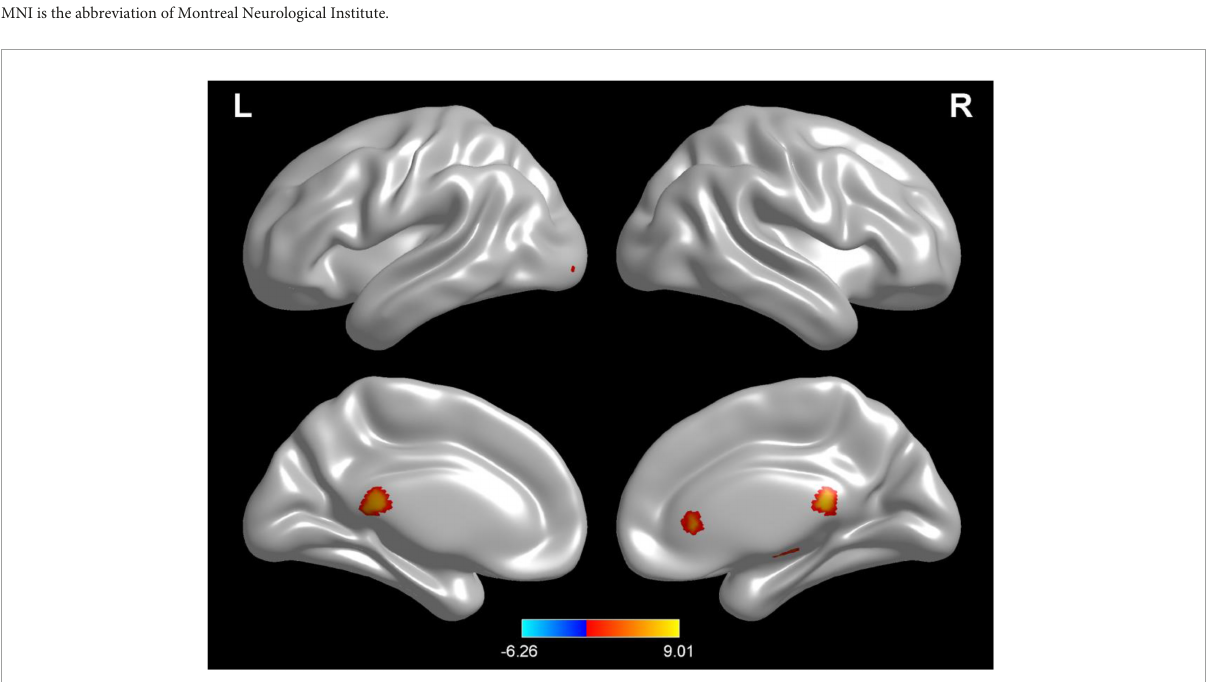
FIGURE3 Regional changes on the voxel-based three-dimensional displayed brain white matter among participants when compared with test 3 in rehydration state and test 2 in dehydration state. Warm colors mean that the white matter density among participants in the rehydration test was higher than that in the dehydration test; cold colors mean that the white matter density among participants in the rehydration test was lower than that in the dehydration test; p < 0.05 after false-discovery rate correction, voxel threshold of cluster >